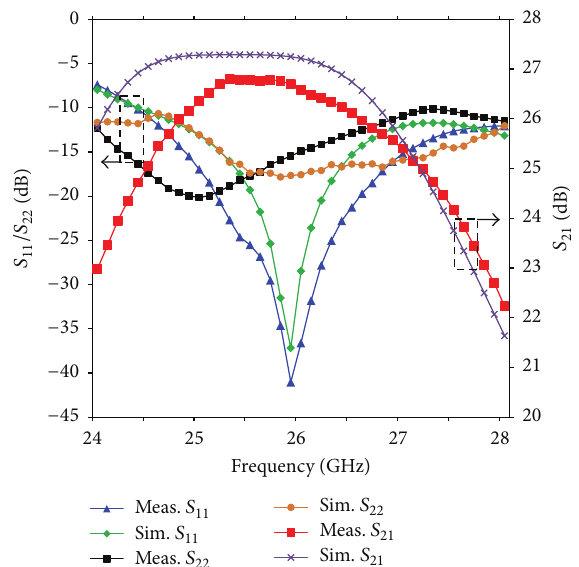
Figure 5: The simulated and measured 𝑆 parameter for the designed PA.